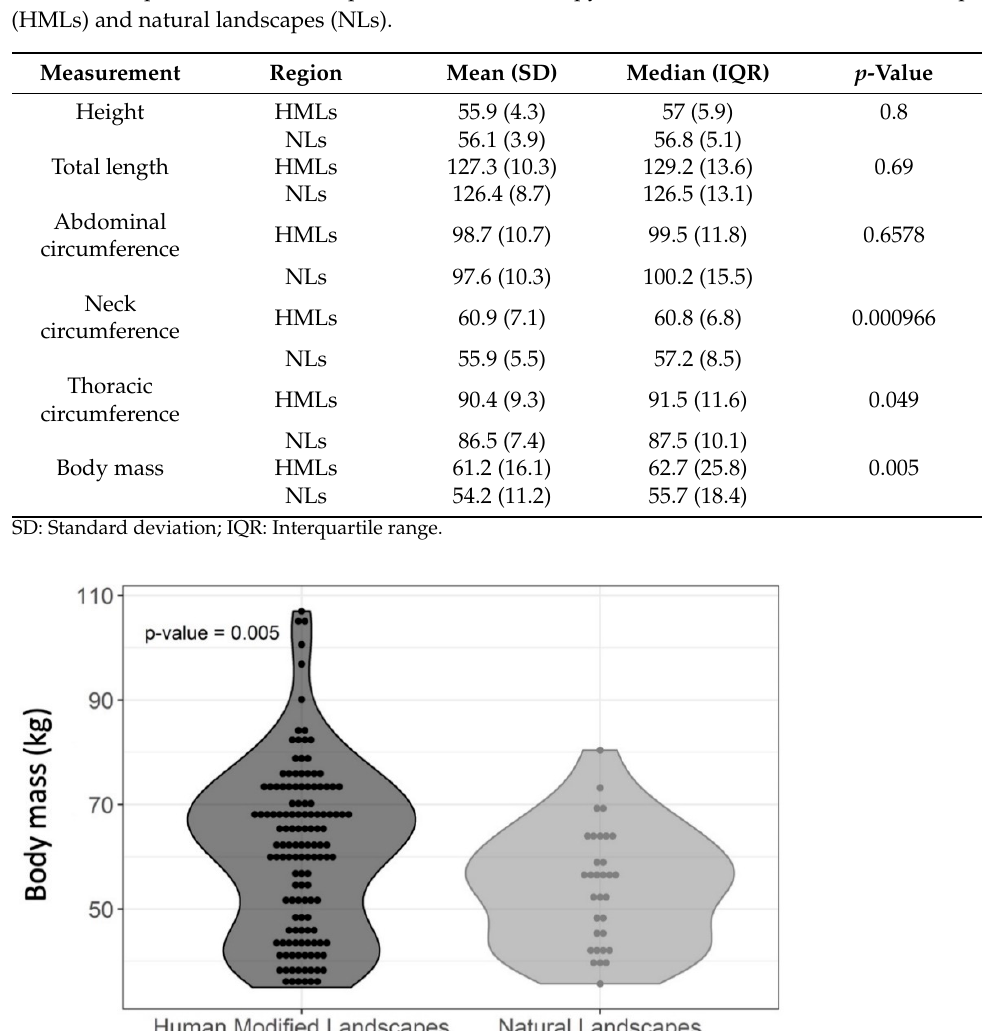
Table 2. Number of adult capybaras sampled by locality of human-modified landscapes (HMLs) and natural landscapes (NLs) in Brazil.